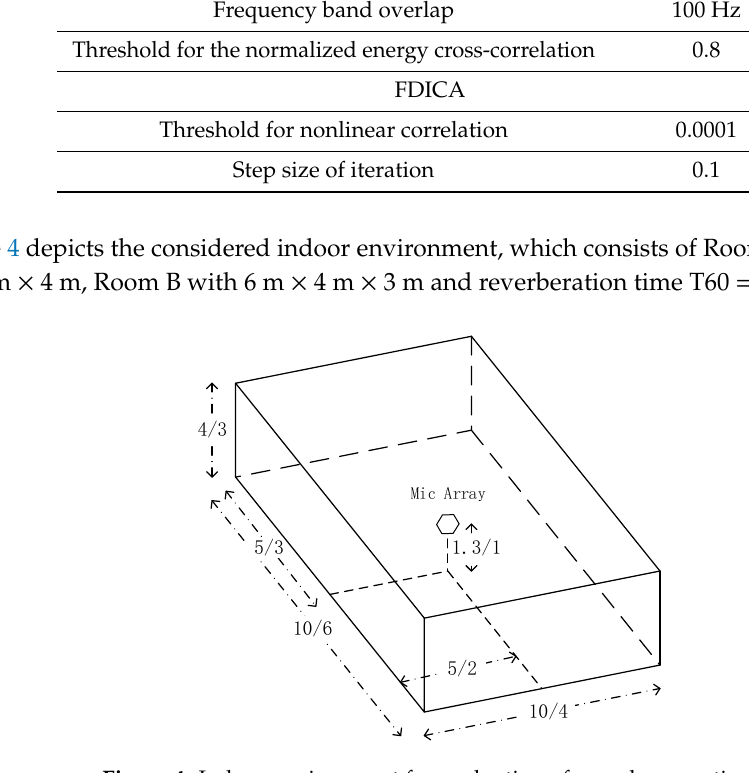
Figure 4. Indoor environment for evaluation of speech separation.